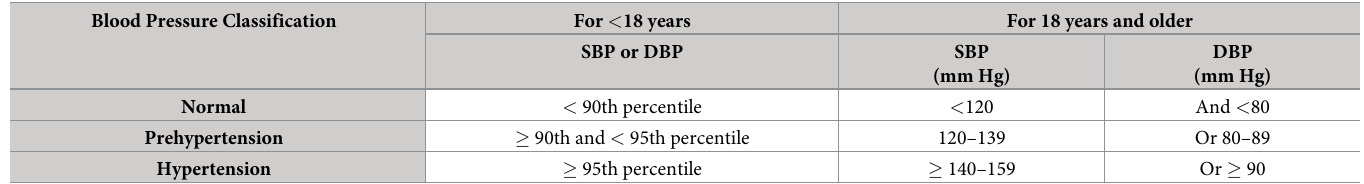
Table 1. Blood pressure classification based on the 4th report and JNC 7. Blood Pressure